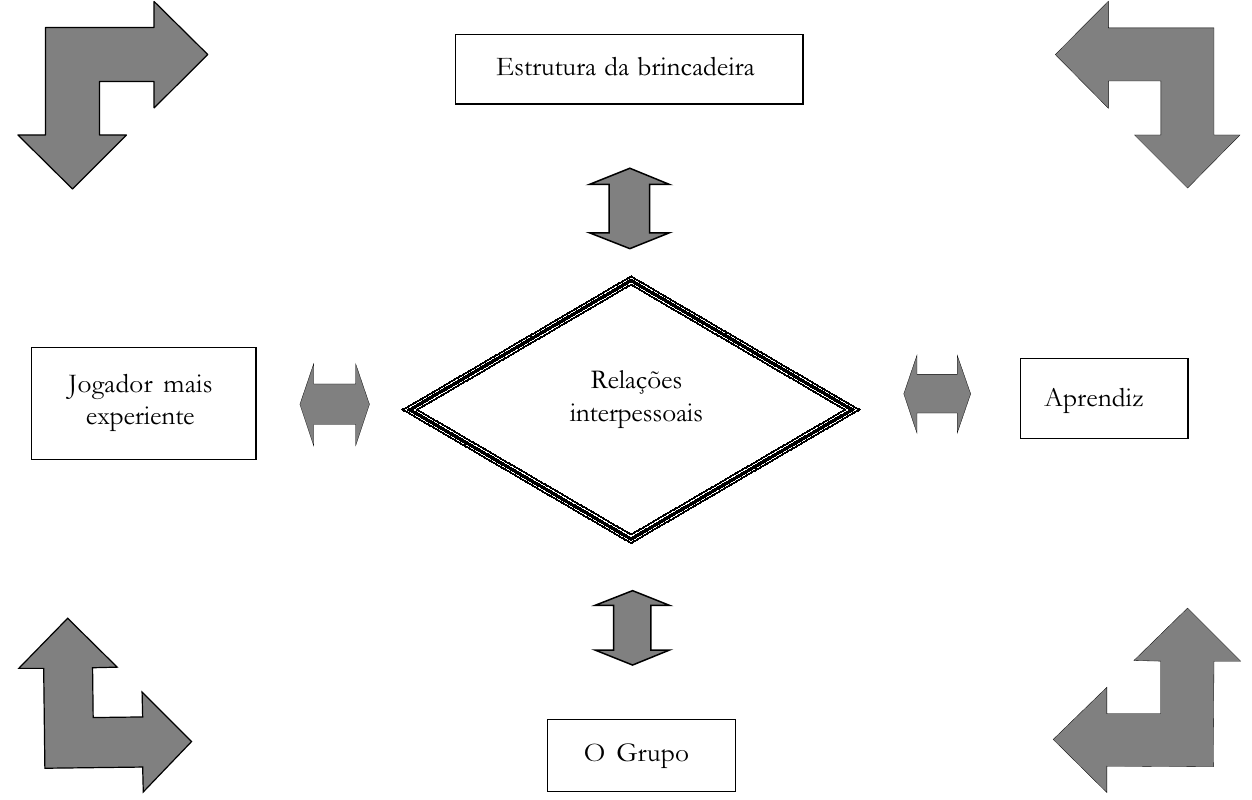
Figura 1. Elementos a serem considerados na anÆlise da transmissªo da cultura